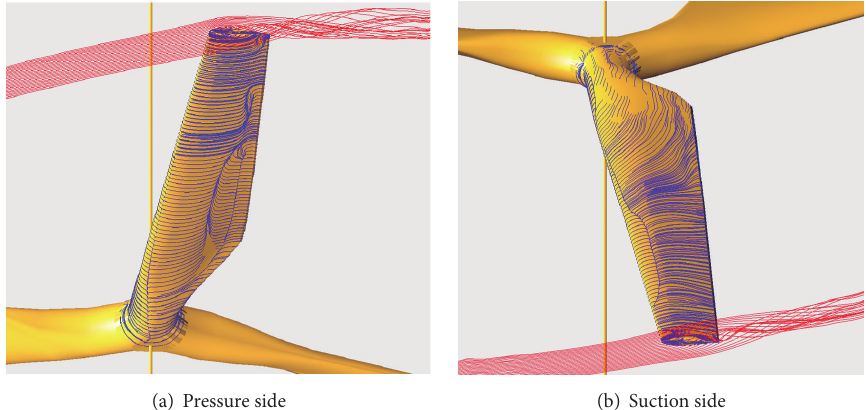
Figure 15: Limiting streamlines on blade surface solved by the unsteady laminar model ( Δ𝑡 = 1/16000 rotation) for 𝜆 = 5